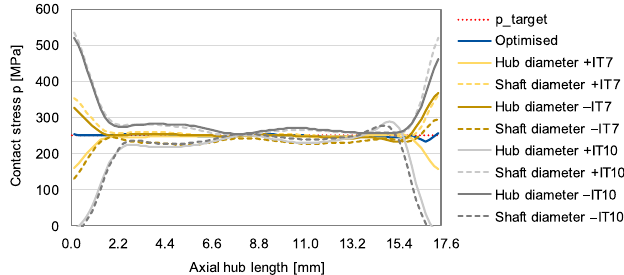
Fig. 10. Contact-stress distribution with respect to hub- and shaft-diameter tolerances.